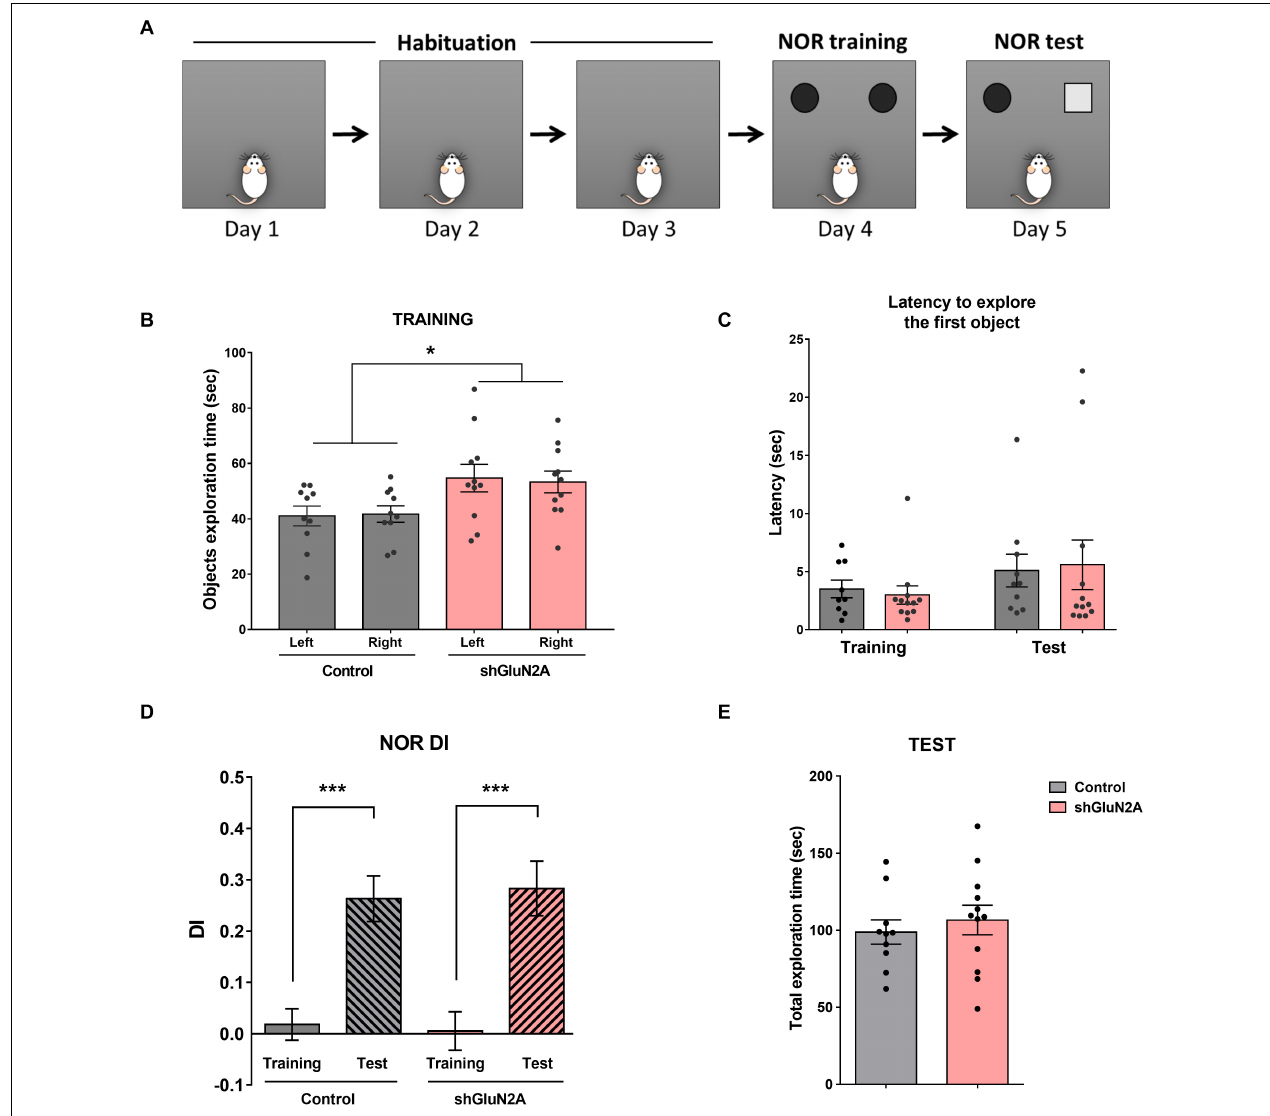
FIGURE 4 | Novel object recognition. (A) Representative scheme of the novel object recognition (NOR) task. Habituation to the arena: three 10-min sessions on consecutive days. NOR training session: rats were exposed to two identical objects for 5 min in the familiar arena. NOR test session: rats were exposed to one familiar and one novel object for 5 min in the arena. (B) Training session: shGluN2A-injected animals showed a significant increase in total object exploration time (* p < 0.05, Two-way ANOVA, Tukey posttest). However, there was no significant difference between exploration of each object in control and shGLUN2A-injected animals. (C) shGluN2A-injected animals showed similar latencies to explore the objects compared to controls during training ( p = 0.6478, unpaired t test) and test sessions ( p = 0.8527, unpaired t test). (D) NOR test session: discrimination index (DI) at training (plain bars) and test (striped bars) were represented. Both groups of animals reached learning criteria DI te significantly different from DI tr (*** p < 0.0001, unpaired t test). (E) There was no difference in total object exploration time during the test session between control and shGluN2A-injected animals ( p = 0.5494, unpaired t test). Data are represented as mean ± SEM. Animals: n = 9 control, n = 11 GluN2A